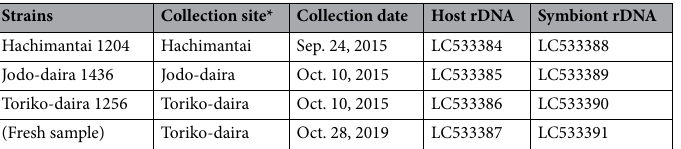
Table 1. Stentor pyriformis strains and GenBank Accession numbers for the host and symbiont rDNA. *See Fig. 1.